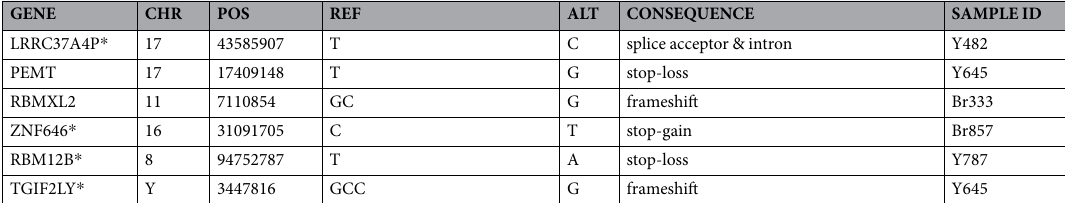
Table 2. Putative dominant loss-of-function candidate genes where at least one sample had a rare protein disruptive variant in the suicide samples.Each genetic variant was a heterozygote. GENE is the name of gene; CHR and POS shows the GRCh37 coordinate of the variant, REF/ALT columns shows the reference and alternate alleles, CONSEQUENCE is the type of the protein disruption, and the SAMPLE ID column contains the sample names in which the given variant was found. * denotes genes without disease association in MalaCards and